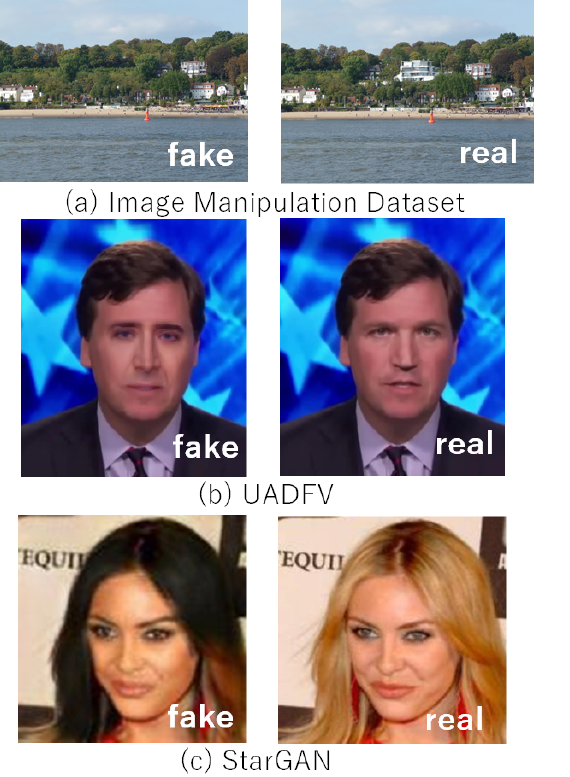
Figure 4. Examples of fake-images in dataset. ( a ) Image Manipulation Dataset; ( b ) UADFV; ( c )